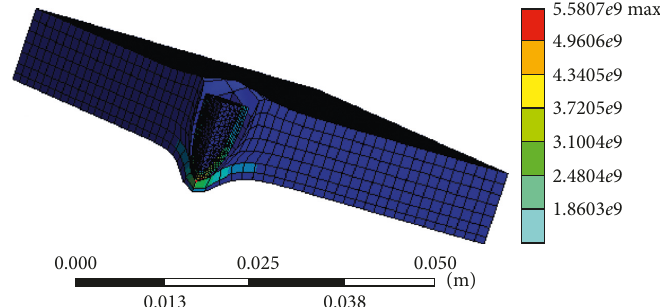
Figure 12: 3D cross section of sample